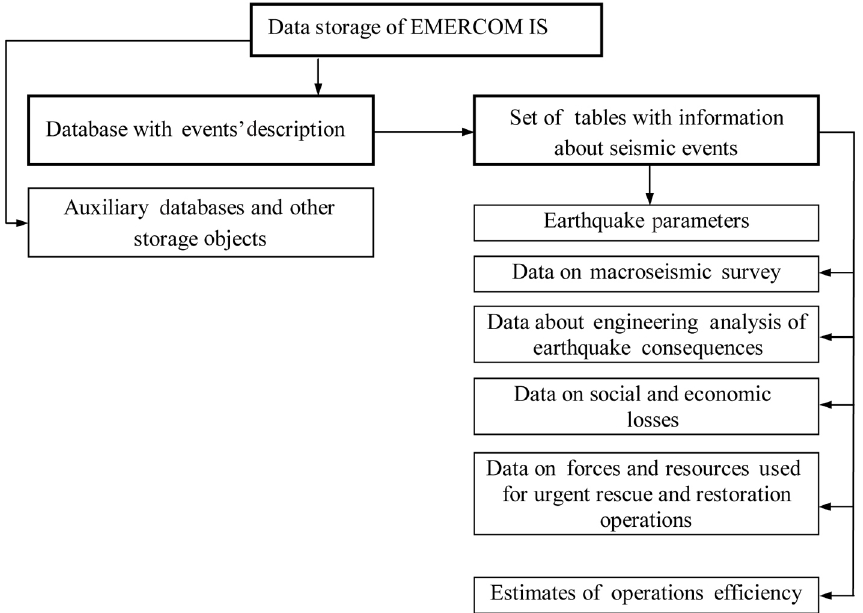
Figure 2. Structure of EMERCOM information system data storage.